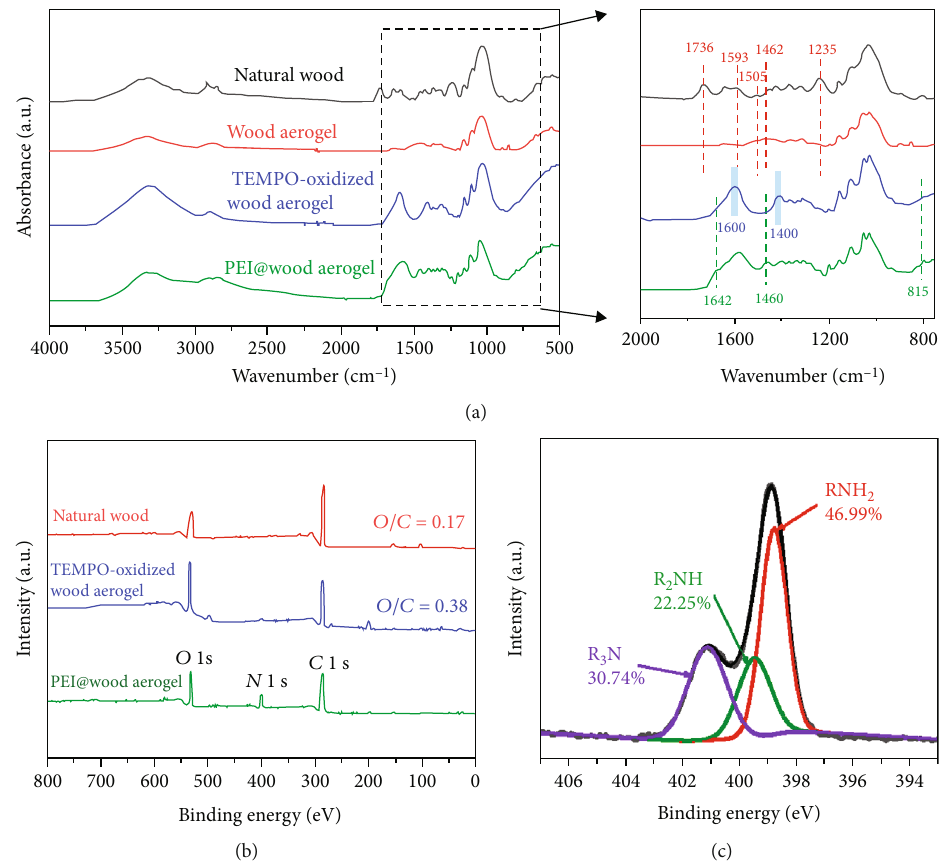
Figure 2: (a) FT-IR spectra of the natural wood, wood aerogel, TEMPO-oxidized wood aerogel, and PEI@wood aerogel; (b) XPS survey spectra of natural wood, TEMPO-oxidized wood aerogel, and PEI@wood aerogel; (c) N 1s spectrum of PEI@wood